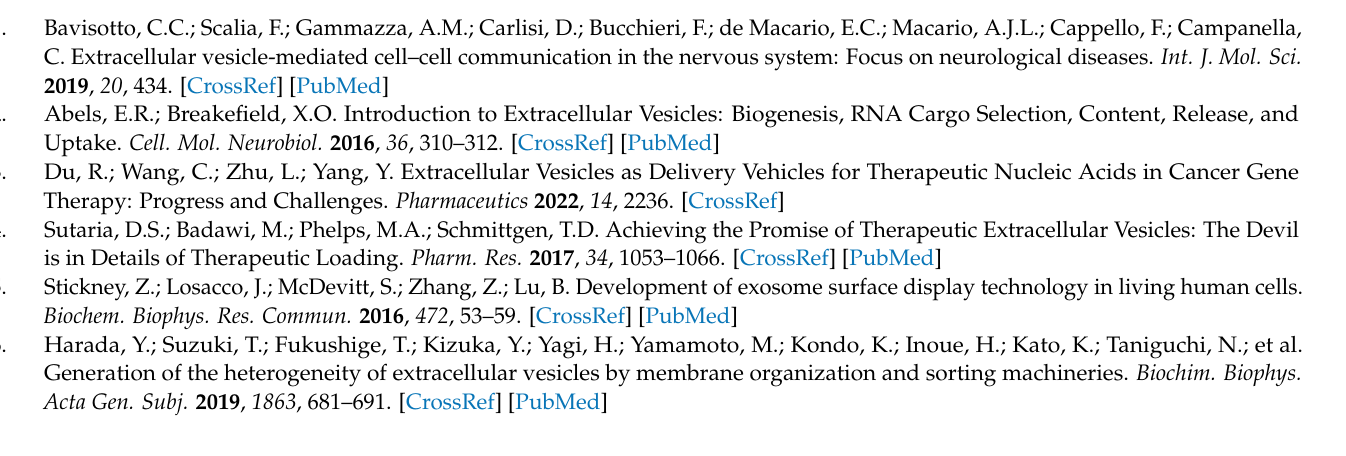
construct. Figure S2: Unmodified western blot gel